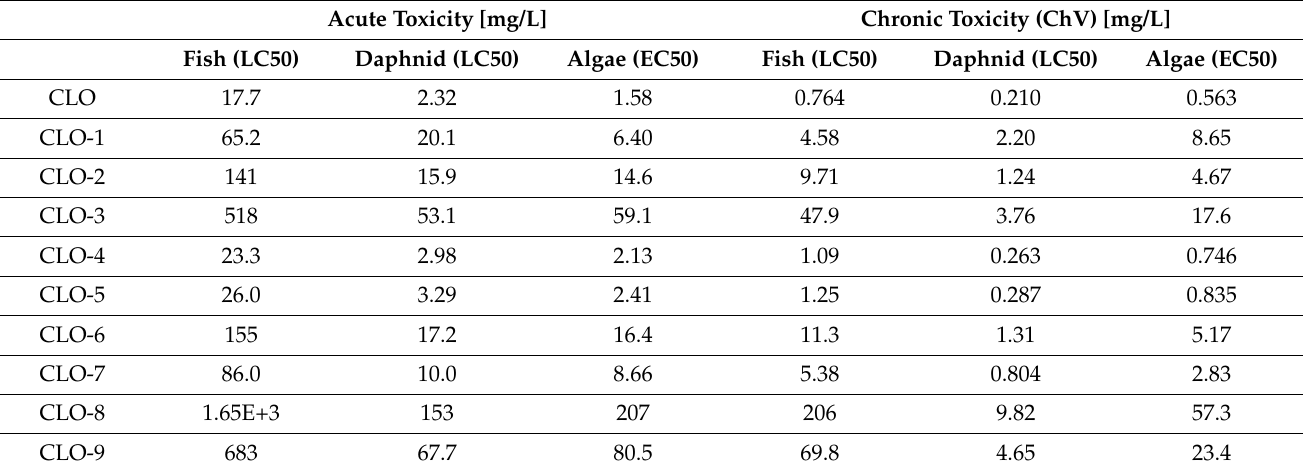
Table 6. Toxicity predictions for CLO and its transformation products using ECOSAR software.